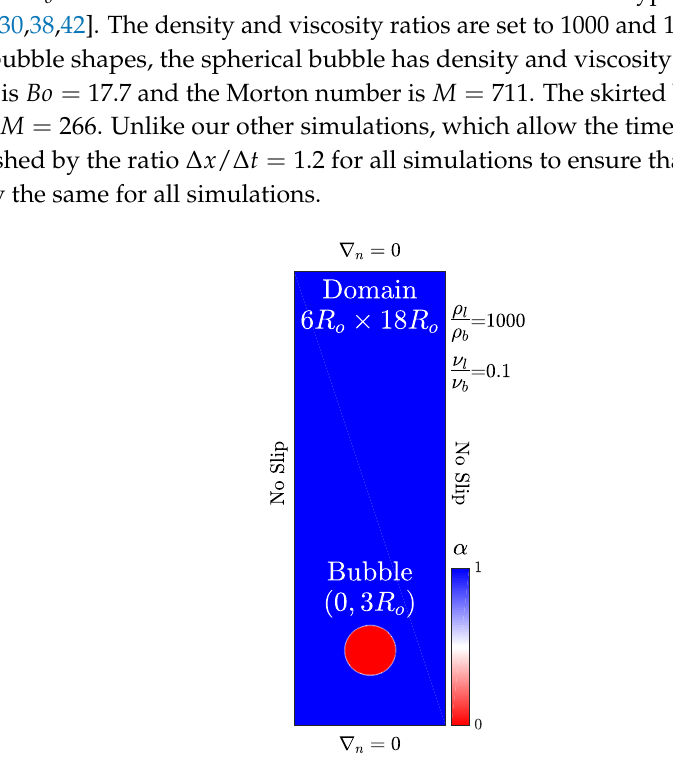
Figure 1. Computational setup of a bubble rising in an initially stagnant liquid. The initial liquid volume fraction is presented with the bubble (red) and liquid